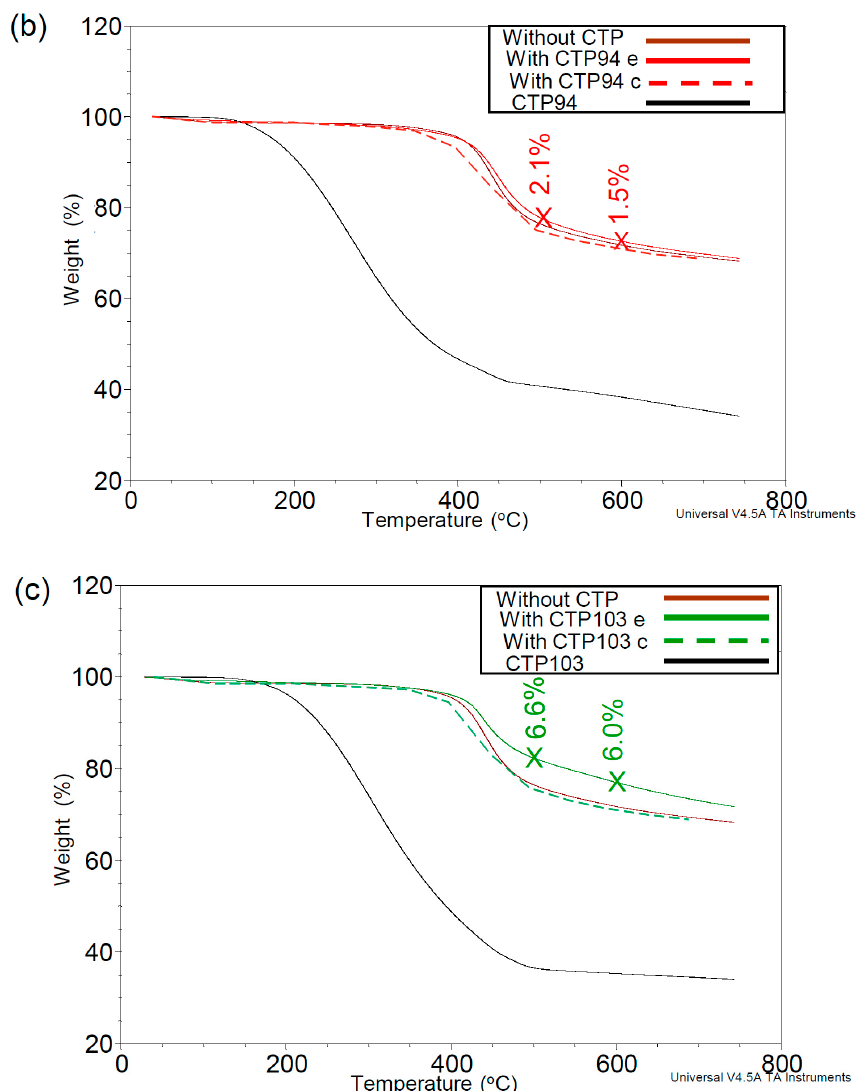
Figure 4. TGA curves of coal, its blends with CTPs and the CTPs: CTP86 ( a ), CTP94 ( b ), and CTP103 ( c ).